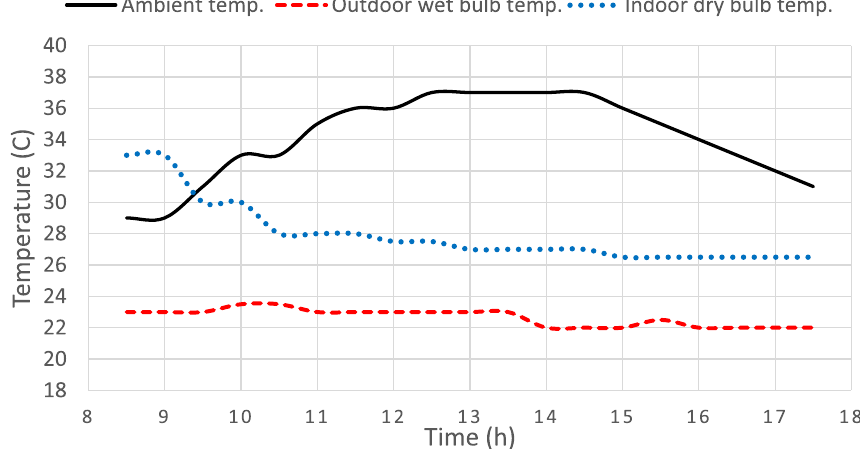
Fig. 10 Variation of temperatures with time for day